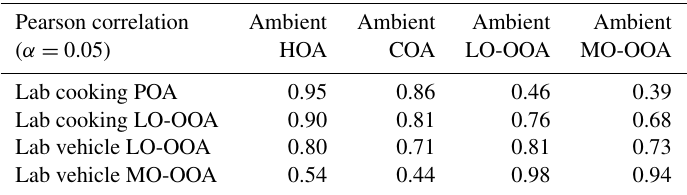
Table 6. Pearson correlations between laboratory OA and ambient OA mass spectra. Pearson correlation Ambient Ambient Ambient